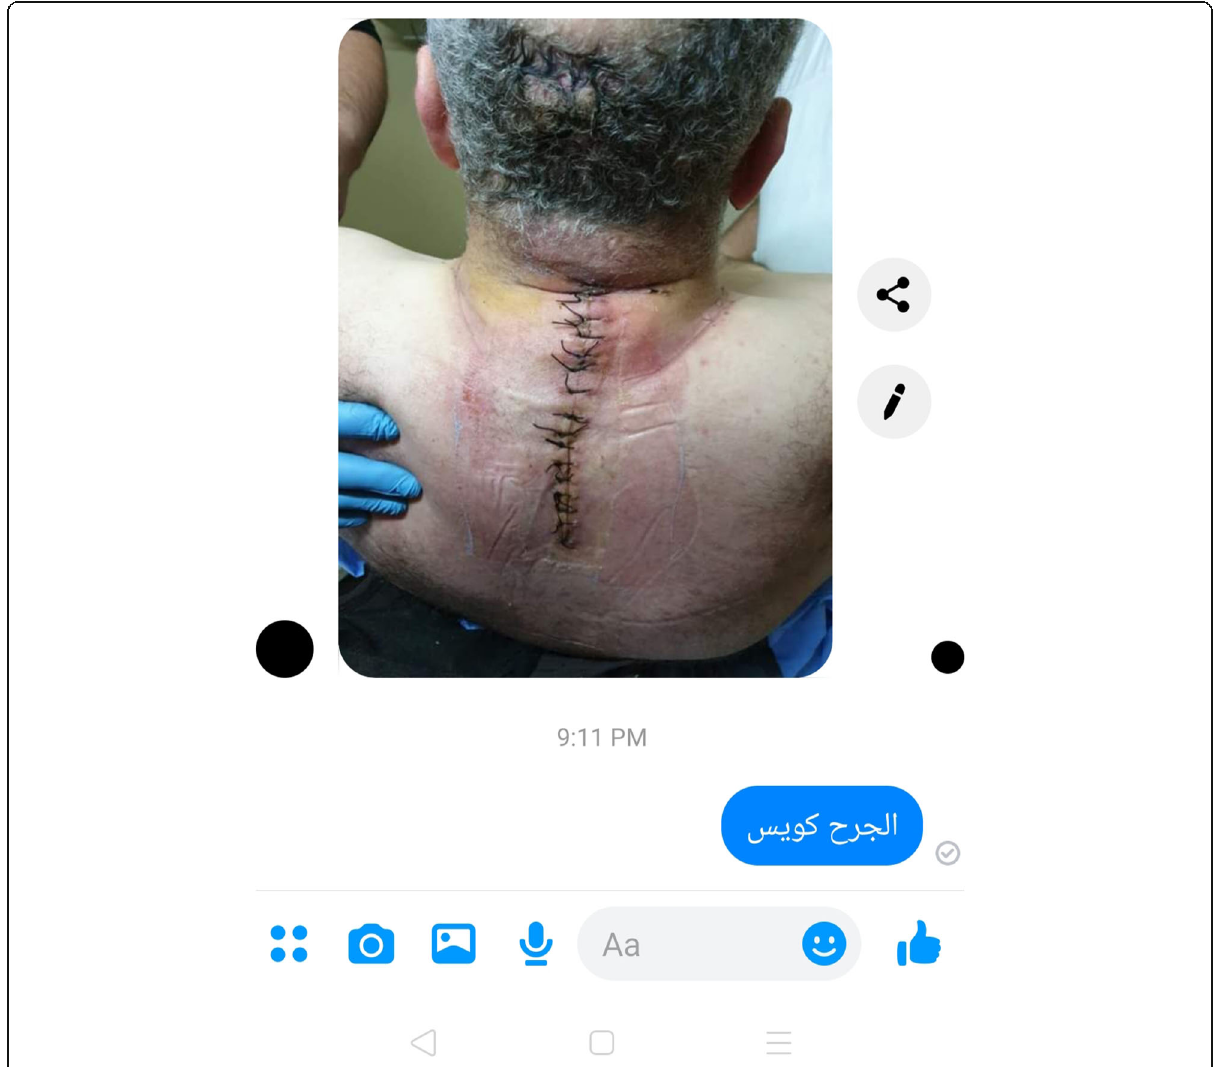
Fig. 2 Telemedicine staff reassures a patient about his wound during online meeting